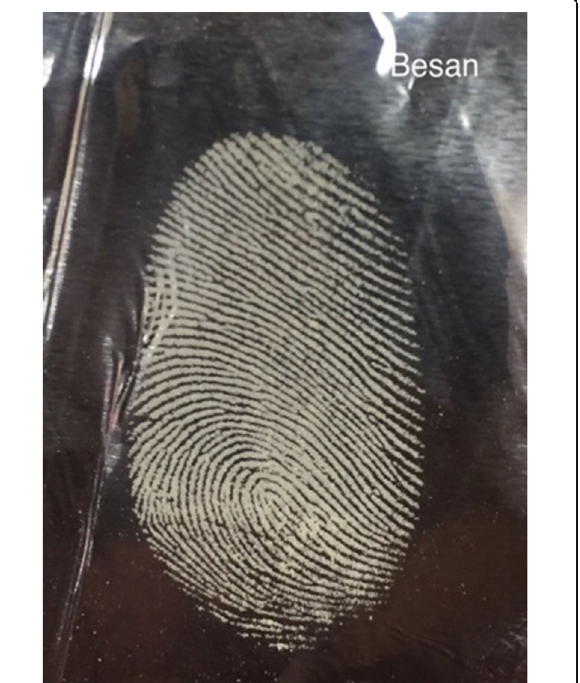
Fig. 9 Development of Latent fingerprint by Gram flour powder on Aluminum Foil